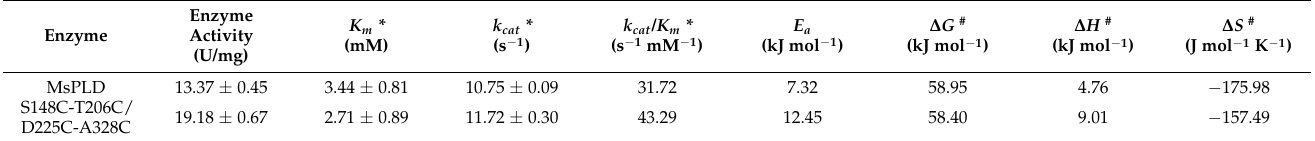
Table 2. Comparison on the kinetic constants of the wild-type MsPLD and mutant S148C-